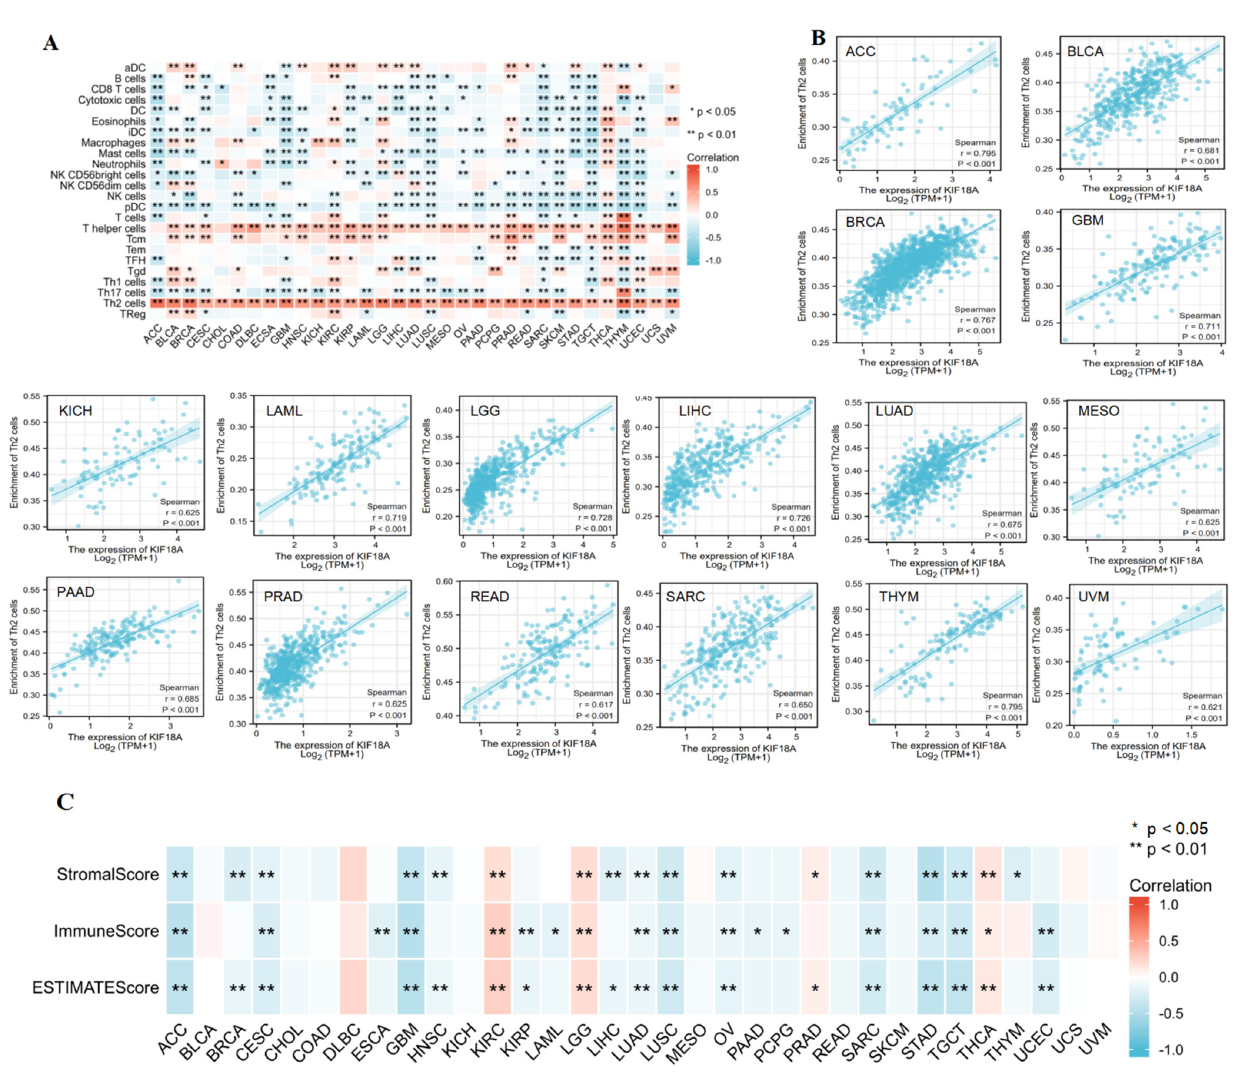
Figure 4. Correlation between KIF18A and immune cells in pan − cancer. ( A ) Heat map of KIF18A expression correlation with 24 tumor infiltrating cells. ( B ) The correlation between KIF18A expression and Th2 cells level in ACC, BLCA, BRCA, GBM, KICH, LAML, LGG, LIHC, LUAD, MESO, PAAD, PRAD, READ, SARC, THYM, and UVM. ( C ) The heat map of the correlation between KIF18A expression and the stromal score, immune